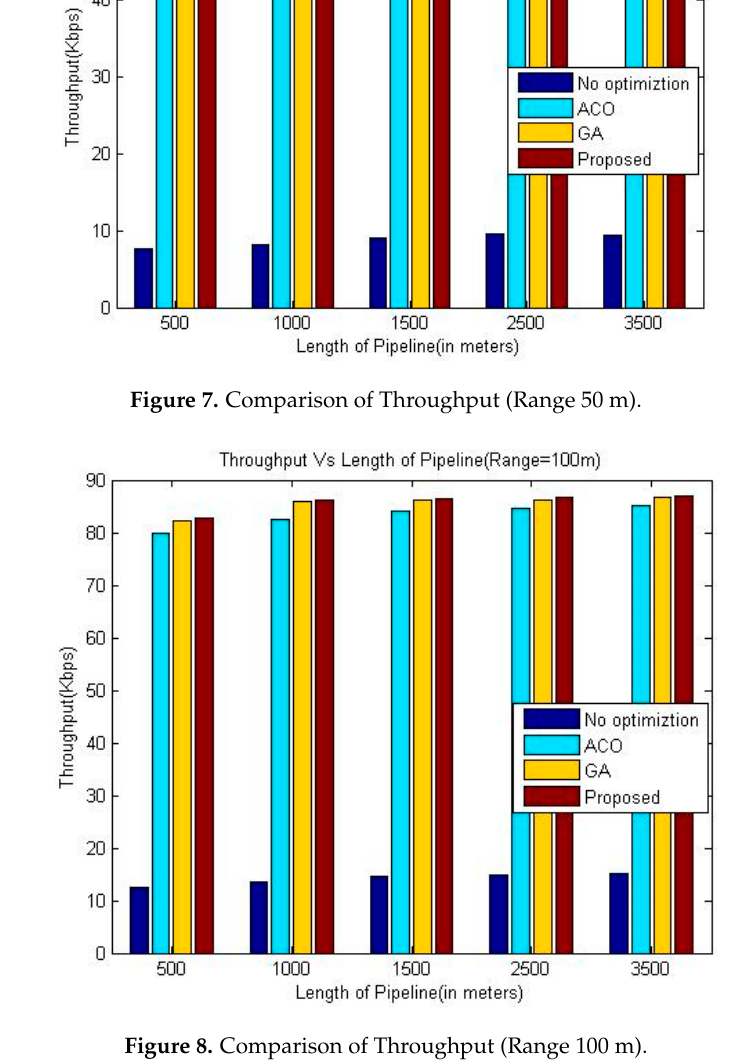
Figure 8. Comparison of Throughput (Range 100 m). Table 8. Comparison of Normalized Life Time (Range 25 m). Length of